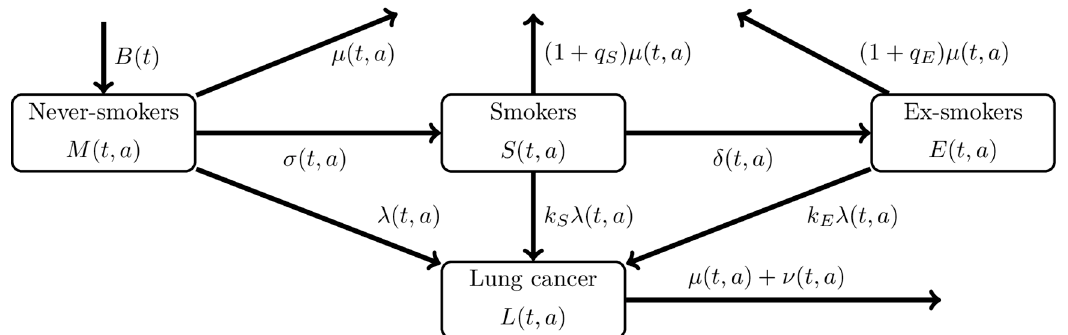
Figure 2. Compartmental model of lung cancer. Compartment diagram of the proposed model to predict lung cancer from the epidemiological, demographic, and smoking data. The population is categorized by smoking and lung cancer status. Never smokers begin smoking at a transition rate σ and move to the compartment of smokers. Smokers cease smoking at a transition rate δ and become ex-smokers. For simplicity and because of the absence of data over long time series, we assume that ex-smokers do not restart smoking. Never-smokers, smokers, and ex-smokers experience different hazard rates of lung cancer at λ , k S λ , and k E λ , respectively. Members of the population in each compartment die at given mortality rates.